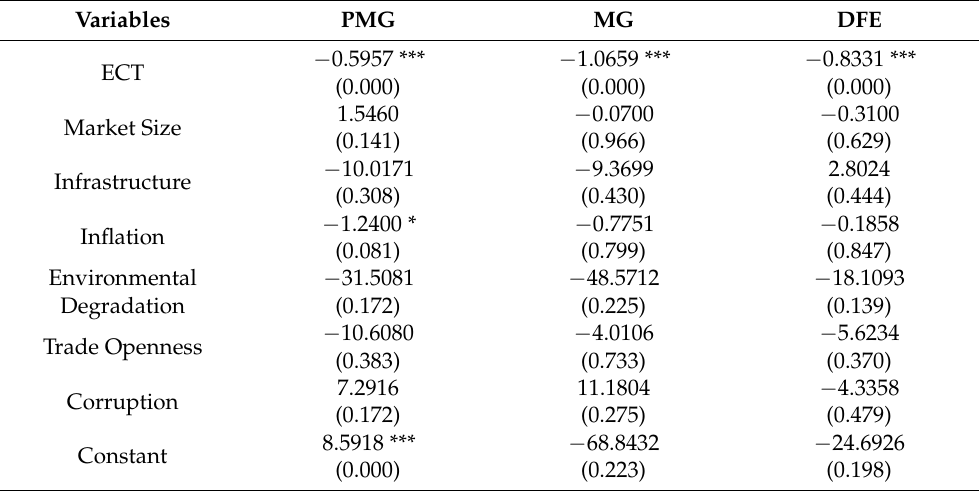
Table 7. Short-Run Estimation Results.